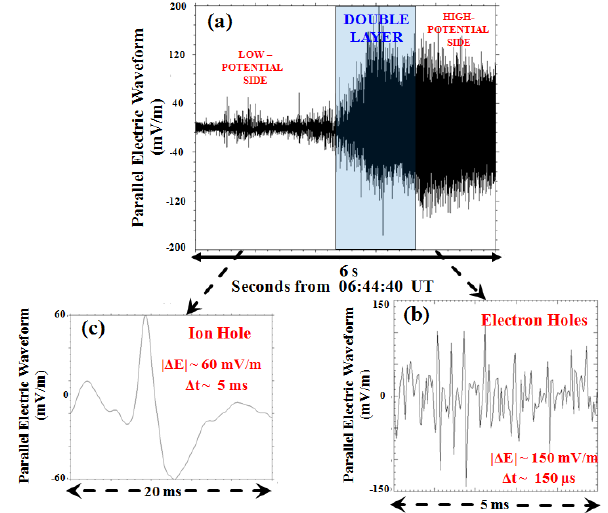
Figure 4. Fluctuations observed in the 32kHz quasi-parallel elec- tric field waveforms measured by FAST in the neighbourhood of a DL. The temporal extension of the anti-earthward parallel electric field corresponds to the blue shaded region (a) . From 06:44:44.713UT bipolar electric field structures are detected on the high-potential side of the DL (b) ; they characterize the presence of EHs which have time spans of about 150µs with amplitudes of ∼ 150mVm − 1 . On the low-potential side of the DL large am- plitude ( ∼ 60mVm − 1 ) electric field structures (ion holes) are also recorded at 06:44:40.630UT; they have time spans of ∼ 5ms (c) .